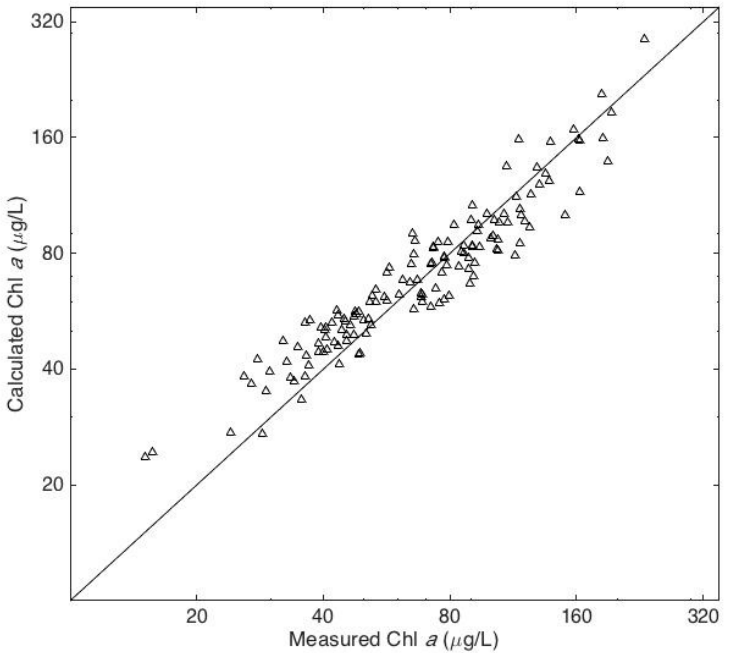
Figure 4. Measured chl a concentrations and the concentrations predicted by multiple linear regression with chl b , fucoxanthin, and zeaxanthin as the independent variables.